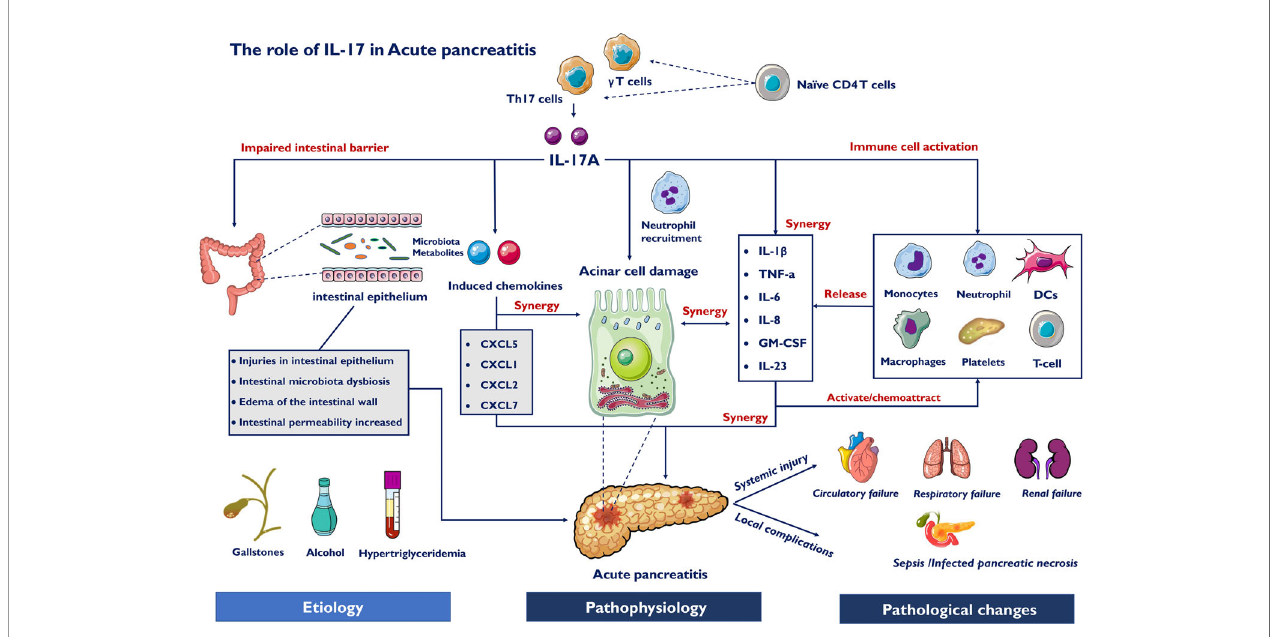
FIGURE 2 | Roles of IL-17 in acute pancreatitis. Etiology for AP include gallstones, alcohol and hypertriglyceridemia, which cause pathophysiological changes of AP. IL-17A induce pancreatic acinar cell damage through synthesizing and releasing cytokines and chemokines which recruit immune cells, such as neutrophils and macrophages. IL-17 also directly induce chemokines and activate innate immune cells, releasing pro-in fl ammatory mediators. Different in fl ammatory factors act in synergy with each other to aggravate AP. Furthermore, the intestinal microbiota-derived signals to IL-17 include microbiota alteration, bacteria-derived metabolites and impaired intestinal barrier function. Systemic injury develops early due to IL-17 involving in fl ammatory response and may precede necrosis, and late secondary organ failure due to infected pancreatic necrosis (IPN) induce